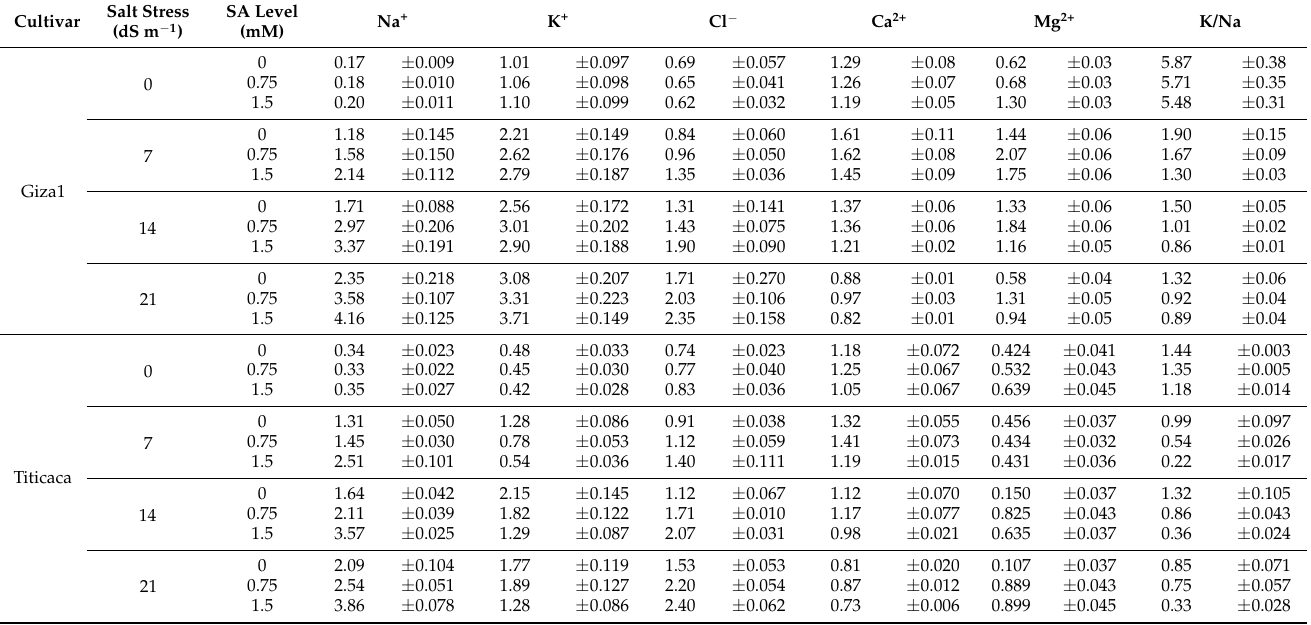
Table 2. The concentrations of ions (%) in quinoa roots treated with varied salicylic acid (SA) concentrations grown under different salinity